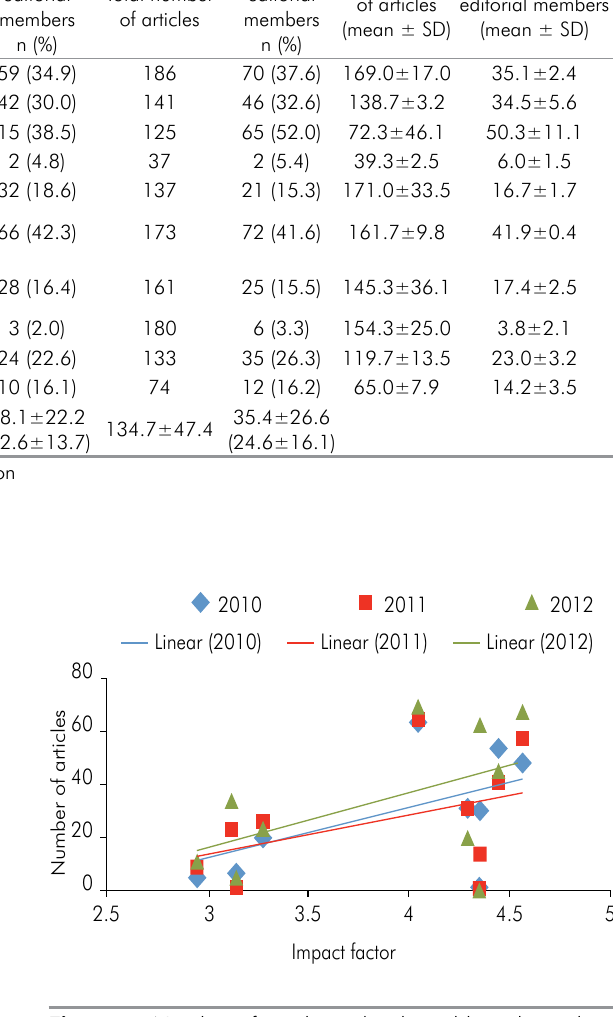
Figure 1. Number of articles with editorial board members as authors by impact factor and year. Lines represent the fitted regression line for each year